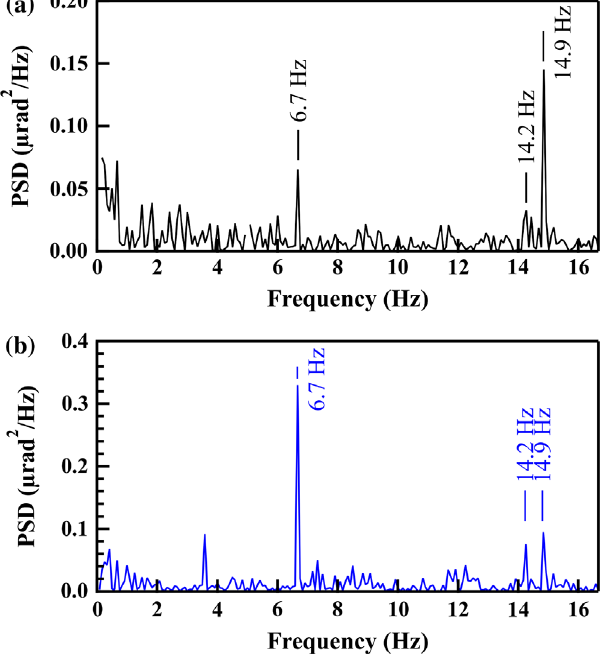
FIG. 5. PSD functions of the beam angle y 0 measured with (a) a Si (220) Laue single-crystal monochromator and (b) a Si (220) Bragg double-crystal monochromator at the barium K edge. Note that the two measurements were performed on different dates with the two monochromators being on different supports located in different hutches. The Laue SCM was radiation cooled in air, while the Bragg DCM has a gravity-fed water cooling system. Therefore, the three frequency peaks marked on both (a) and (b) are not from the monochromator, which is the only optics in the